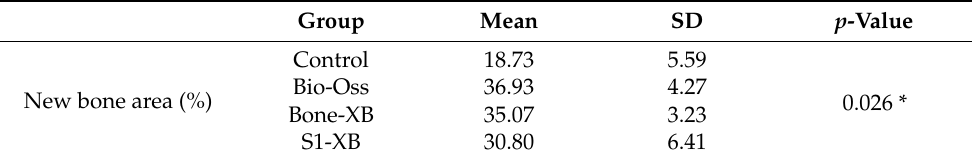
Table 4. New bone area within areas of interest (AOIs).